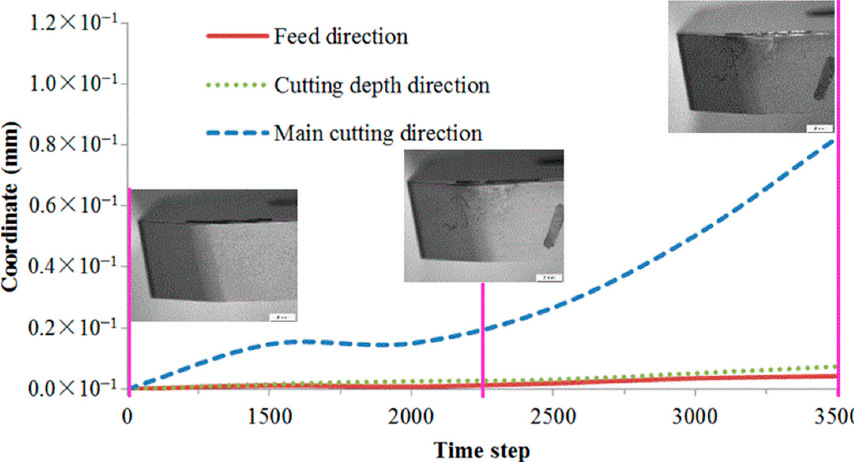
Figure 12. Contrast curve of maximum displacement of material points in three directions.